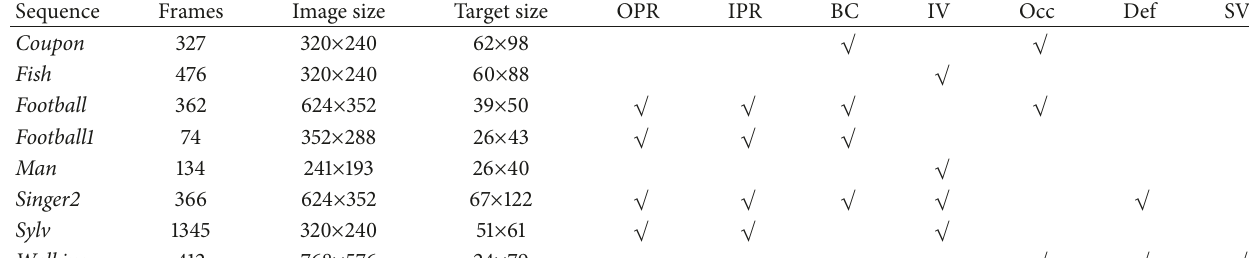
Table 2: The main attributes of the 8 video sequences. Target size: the initial target size in the first frame; OPR: out-of-plane rotation; IPR: in-plane rotation; BC: background clutter; IV: illumination variation; Occ: occlusion; Def: deformation; SV: scale variation.